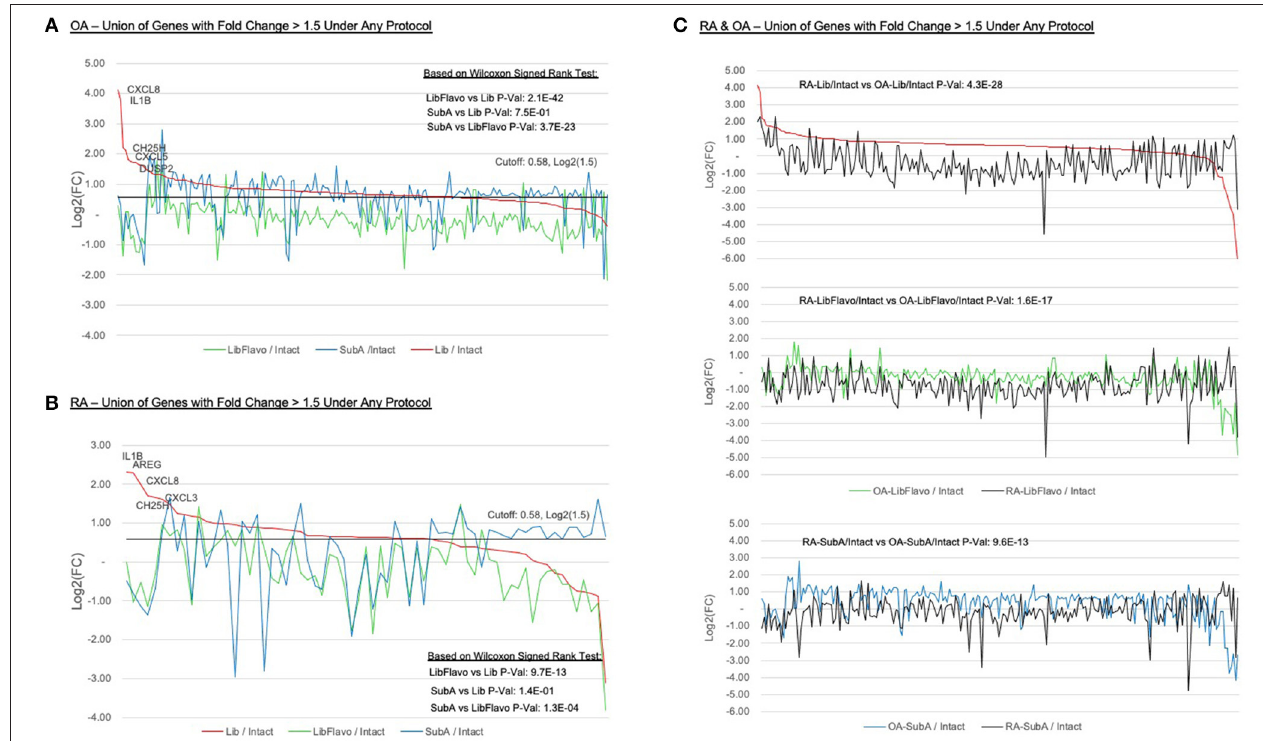
FIGURE 4 | Expression ratios of induced genes under treatment protocols. Relative expression of all genes with > 1.5-fold induction in each protocol relative to intact in OA (A) and RA (B) . Y-axis indicates log2(Protocol/Intact) value for each selected gene. “Zero” on the y-axis indicates no change in expression between protocol and intact. Genes are ordered by fold induction observed in Lib compared to Intact. Lines colors represent the disaggregation protocols. P -values calculated using Wilcoxon signed-rank method. (C) Inducement levels of all genes with > 1.5-fold induction in each protocol relative to intact, displaying both OA (colored line) and RA (black line) for each protocol. Genes are ordered by fold induction observed in Lib compared to intact. P -values calculated using Wilcoxon signed-rank method. A greater difference in the RA and OA lines in each protocol indicates a greater difference in induction levels by that protocol for OA and